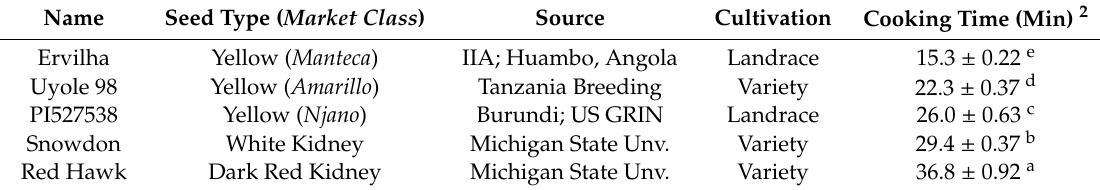
Figure 1. Photographs depicting the five genotypes used to evaluate the iron bioavailability of the African yellow bean. To compare differences in seed sizes, all photographs were taking to scale under standardized lighting conditions. Table 1. Description, Sources, Cultivation Status, and Cooking Times of the Five Genotypes Used to Evaluate the Iron Bioavailability of Yellow Beans from Africa and Kidney Beans from North America.